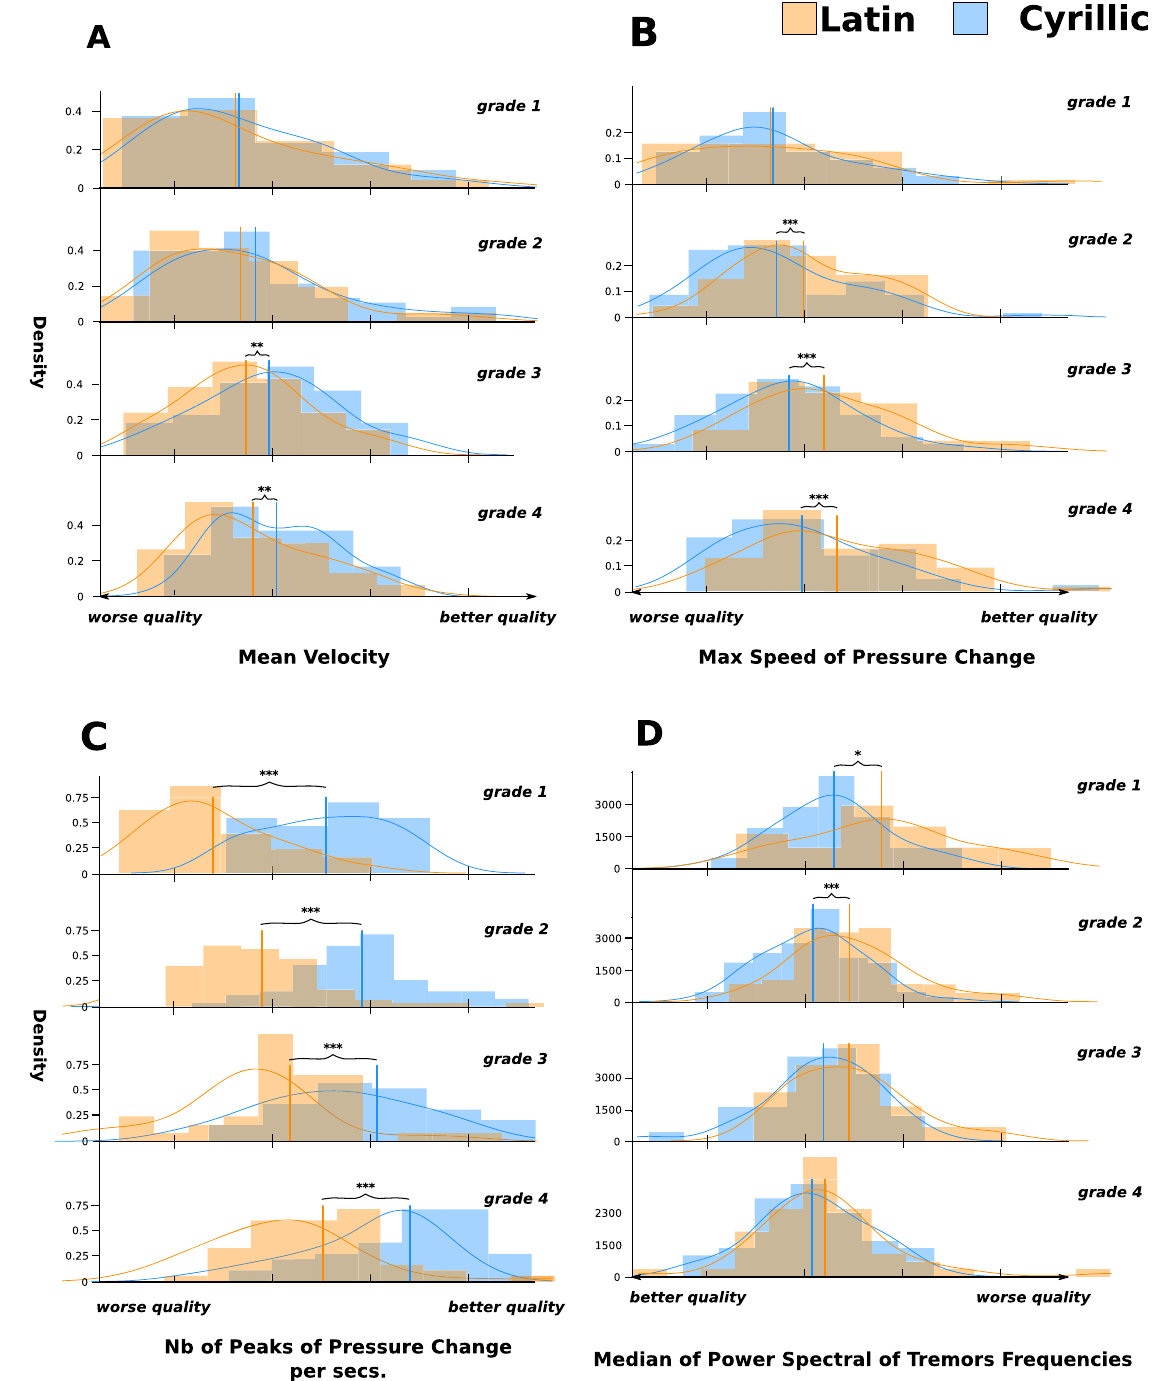
Fig. 2 Distributions of the given features according to grade for the two alphabets (Cyrillic alphabet in blue, Latin alphabet in orange). The vertical lines represent the means of the distributions. A Mean Velocity feature. B Mean speed of the pressure change feature. C Nb of the peaks of pressure change per sec. D Median of the power spectral of tremor frequencies. The handwriting quality aspect along the x -axis was computed according to the Latin standard. Asterisks denotes statistical level of signi fi cance (* p < 0.05, ** p < 0.01, and *** p <